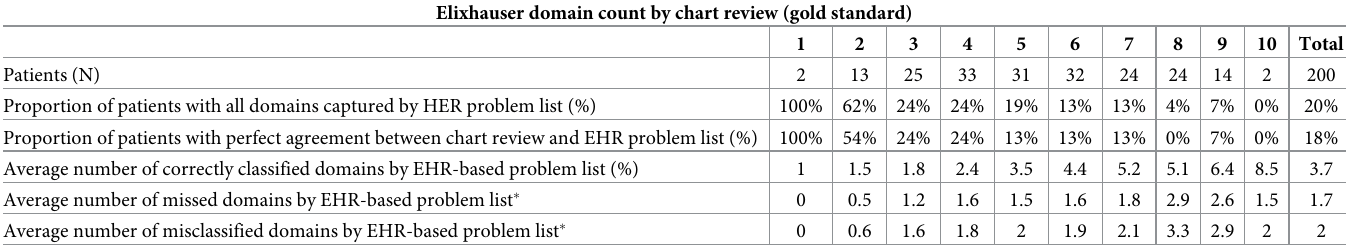
Table 3. Overall accuracy of the EHR-based problem list stratified by level of multimorbidity reported in chart review. Elixhauser domain count by chart review (gold standard)